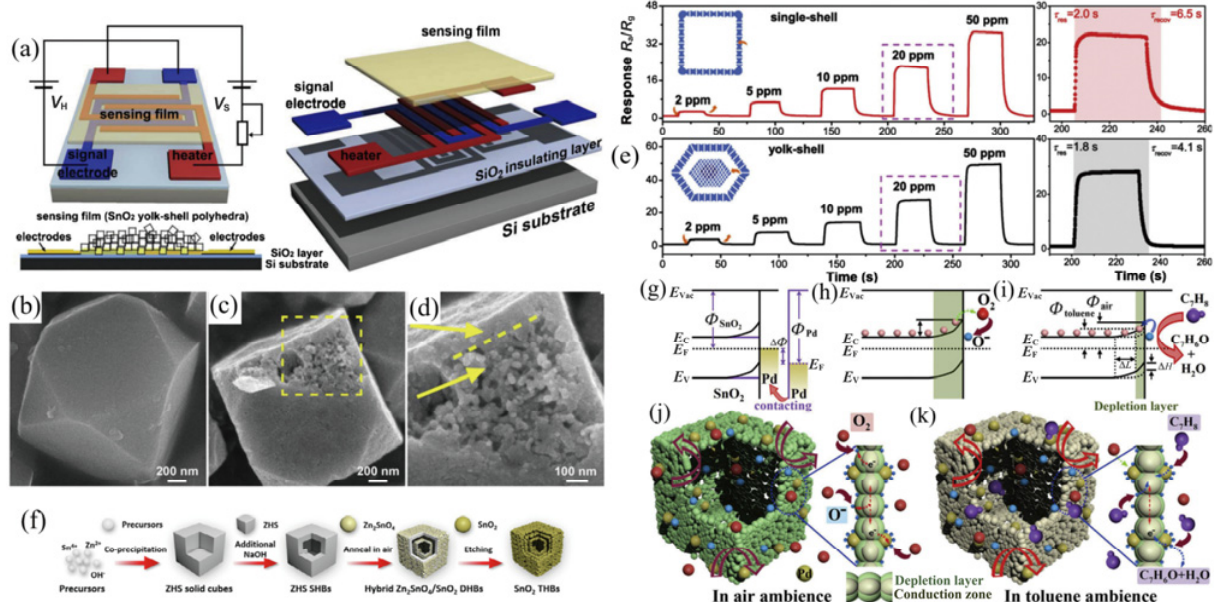
Fig. 5 (a) Schematic diagrams with different perspectives showing the sensor structure based on SnO 2 products. (b–d) Typical field-emission SEM (FESEM) images of Zn 2 SnO 4 /SnO 2 cuboctahedron. (e) Dynamic toluene sensing transients of SnO 2 products with single-shell structures and yolk–shell structures to toluene with different concentrations. (f) Schematic illustration of the overall process for SnO 2 THBs. Schematic energy band diagrams of SnO 2 and Pd contact (g) with establishing the contact and with being exposed to (h) air and (i) toluene ambience. (j, k) Schematic diagrams of possible gas sensing mechanisms of Pd-loaded SnO 2 porous cages. Reproduced with permission from Ref. [87] for (a–e), © Elsevier B.V. 2016; Ref. [88] for (f), © Elsevier B.V. 2020; Ref. [89] for (g–k), © Elsevier B.V.